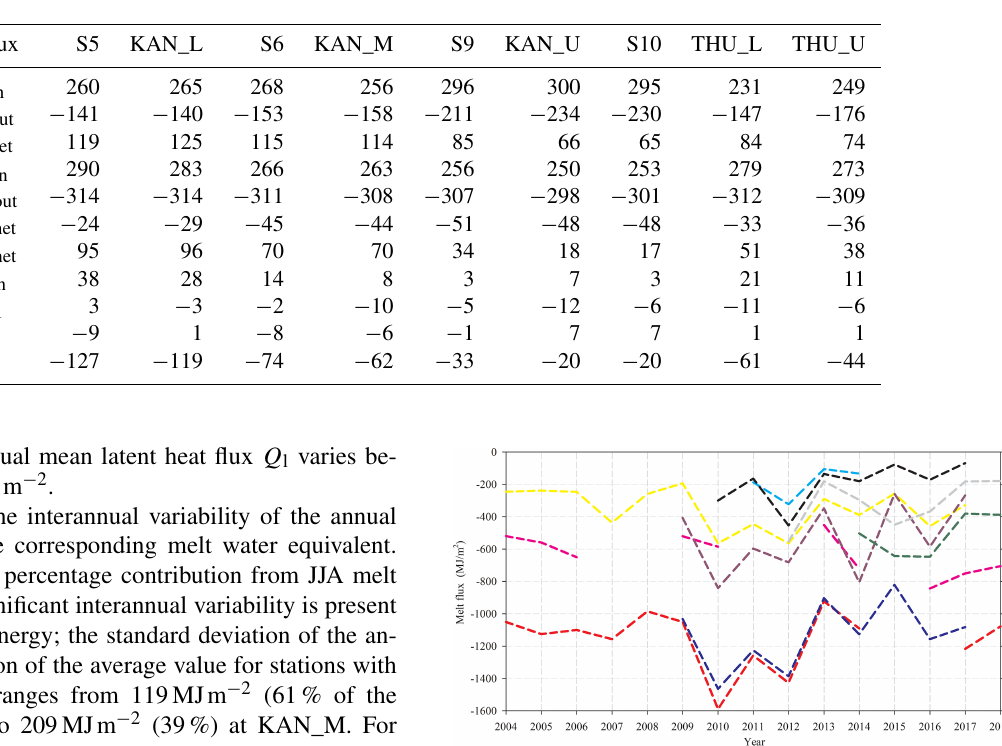
Table 4. Energy fluxes (Wm − 2 ) averaged over June, July and August (JJA) at the nine AWS locations. SEB values of L out , Q h , Q l , G and M are derived from the SEB model, while S in , S out and L in are from observations.